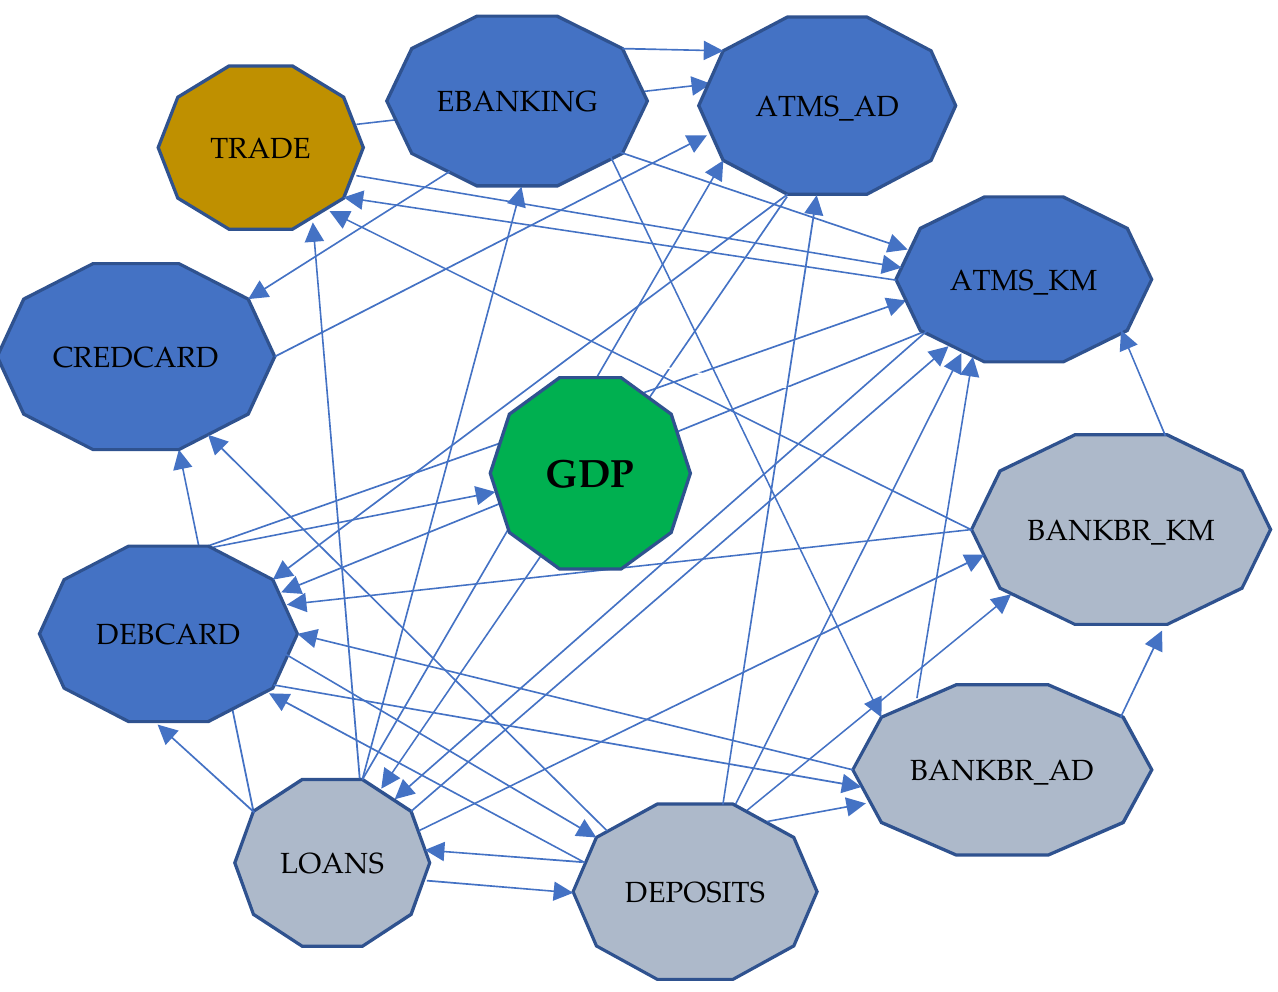
Figure 2. Pairwise Dumitrescu–Hurlin panel causality test.